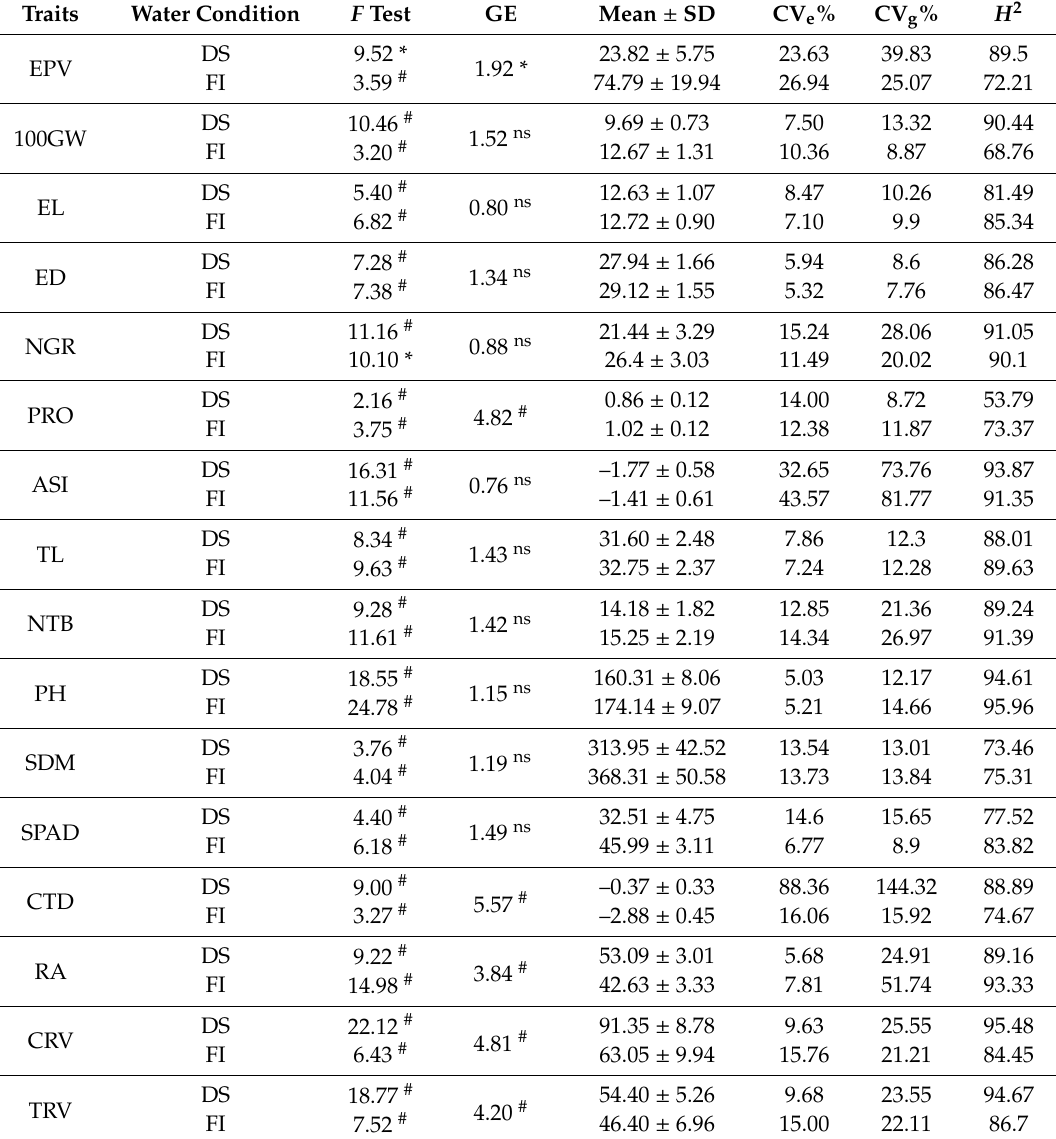
Table 1. Summary of analyses of variances in popcorn lines under full irrigation (FI) and drought stress (DS), genotype–environment (GE) interactions, general means, standard deviations (SD), ( H 2 ), for agricultural, morphological, physiological and root architecture